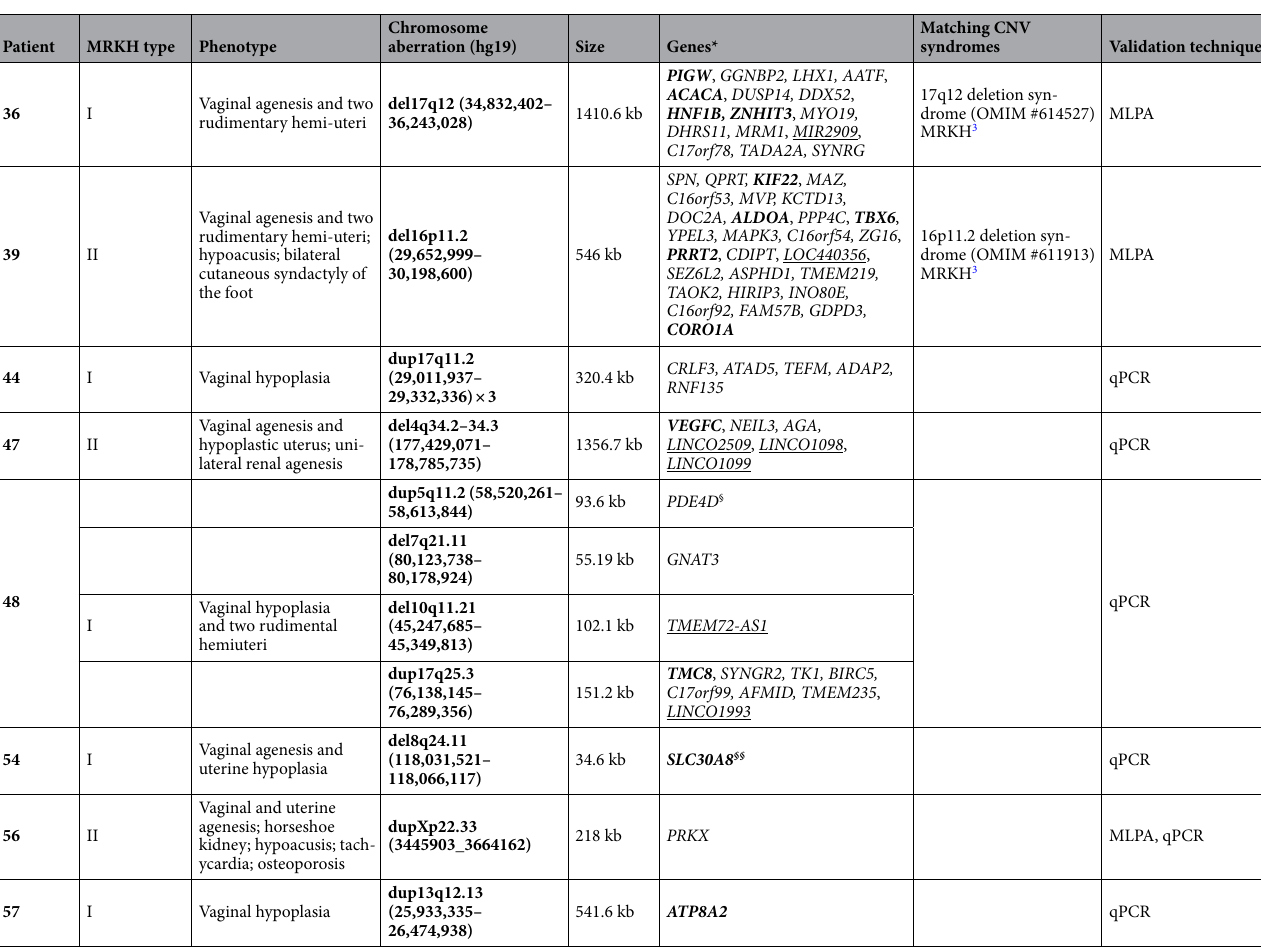
Table 1. CNVs found by array-CGH analysis in the whole cohort of MRKH patients. *In bold are reported OMIM disease-genes, in underline are reported non-protein coding gene. § The duplication includes the first exon of NM_001197220, transcript variant 6, of the gene. §§ The deletion includes the first exon of NM_001172815, transcript variant 5, of the